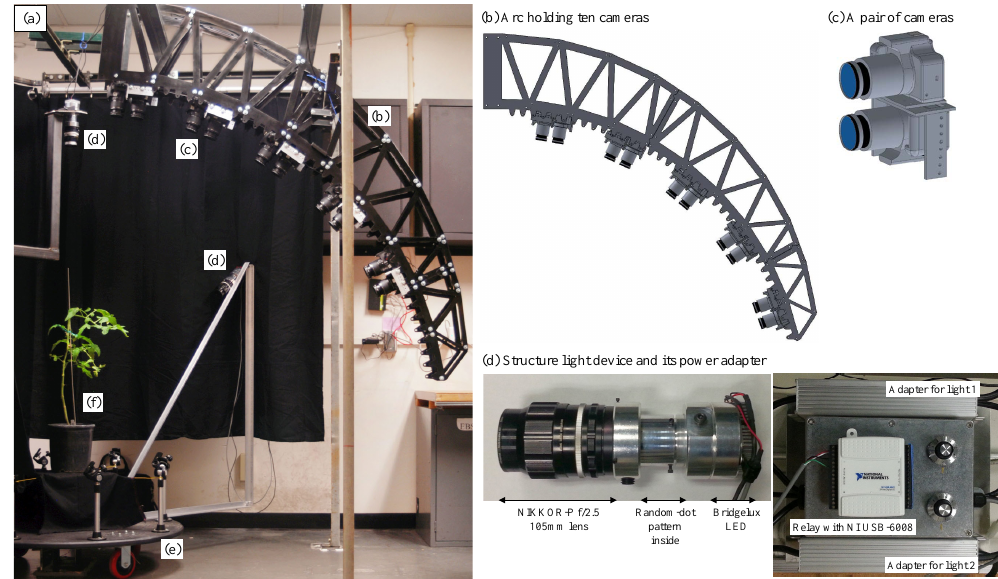
Figure 1. Mechanical structure ( a ) of the 3D reconstruction system: ( b ) the arc holding ten Canon EOS Rebel T3 cameras; ( c ) a pair of cameras where the second camera is upside down relative to the first one; ( d ) structured light devices and their power adapters with a relay controlled by a digital I/O control NI USB-6008; ( e ) a turn-table that rotates the plant 360 degrees; and ( f ) the target